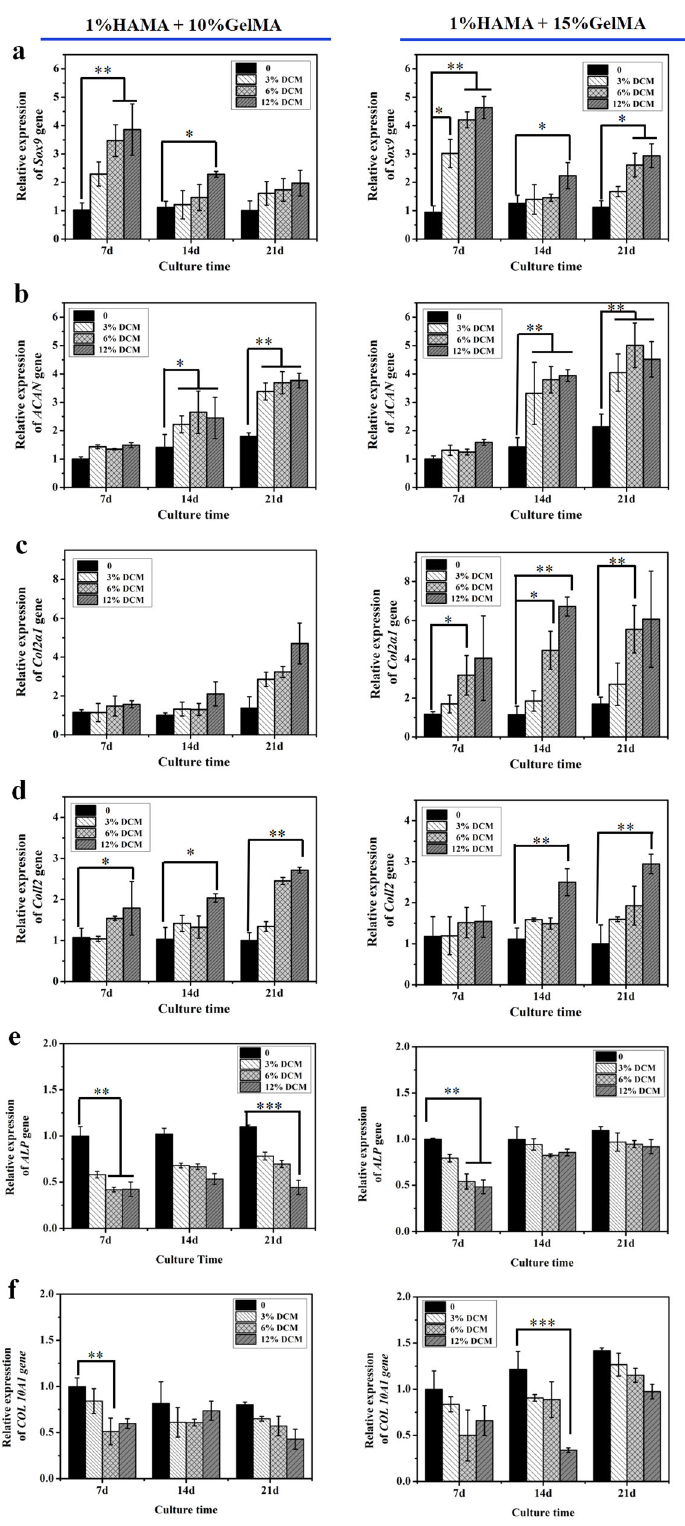
Fig. 5 Quantitative analysis of chondrogenic differentiation and hypertrophy was evaluated by RT-PCR in vitro. The main markers of chondrogenic and hypertrophic differentiation include Sox9 ( a ), ACAN ( b ), Col2 α 1 ( c ), Coll2 ( d ), ALP ( e ) and Col 10A1 ( f ). Representative genes of cell chondrogenesis at different stages and marker genes of hypertrophy were selected. (Error bars: ± SD, * p < 0.05, ** p < 0.01, *** p <